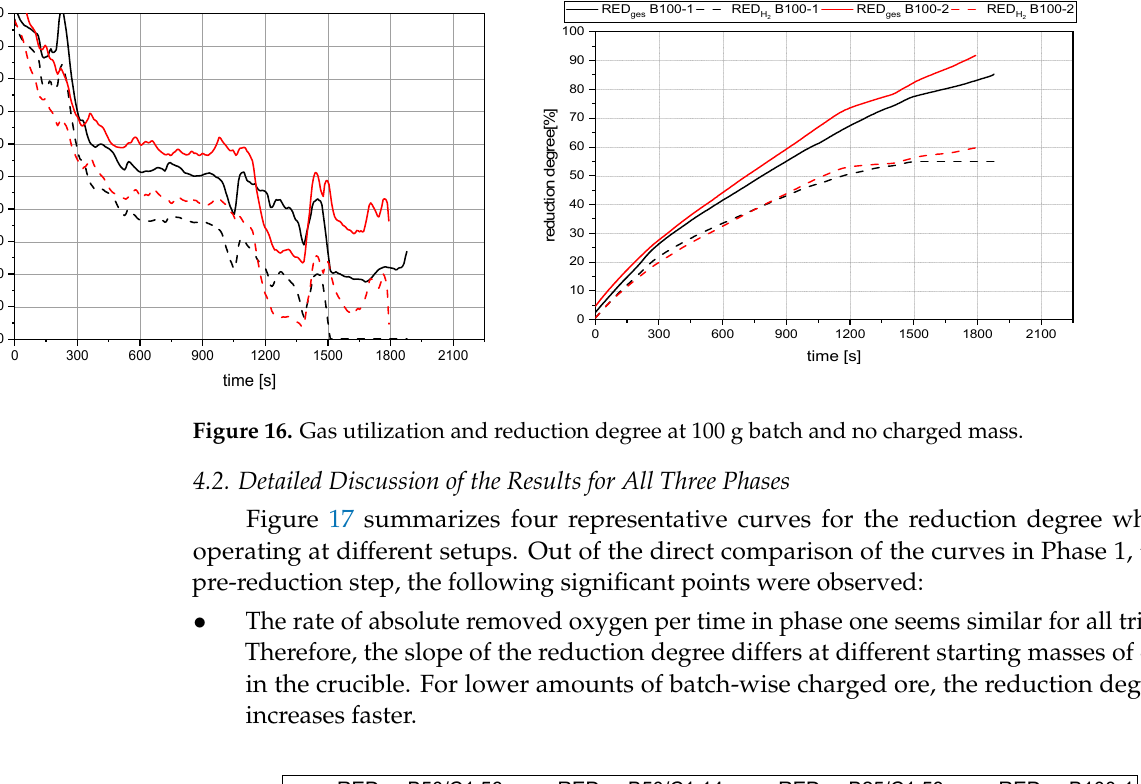
Figure 15. Gas utilization and reduction degree at 50 g batch and 50 g charged mass at 40 rounds per minute of the dosing unit.